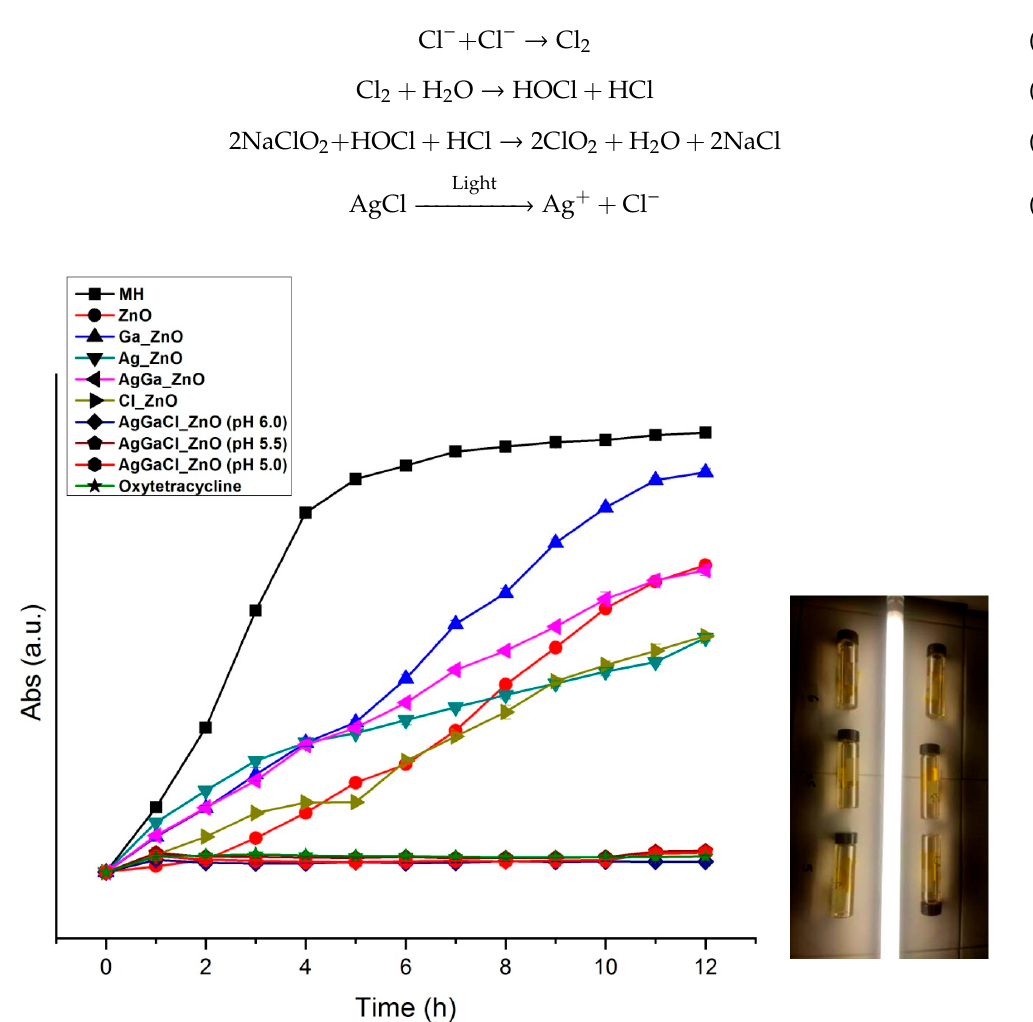
Vibrio parahaemolyticus cell culture growth kinetics for undoped, AgGa-doped and AgGaCl-doped ZnO NRs. Inset: growth kinetics experiment.